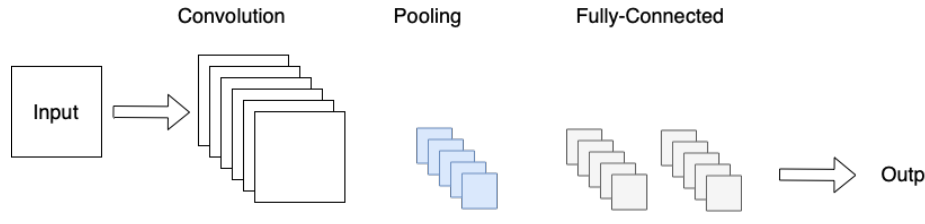
Figure 2. Example of Convolutional Neural Networks (CNNs)